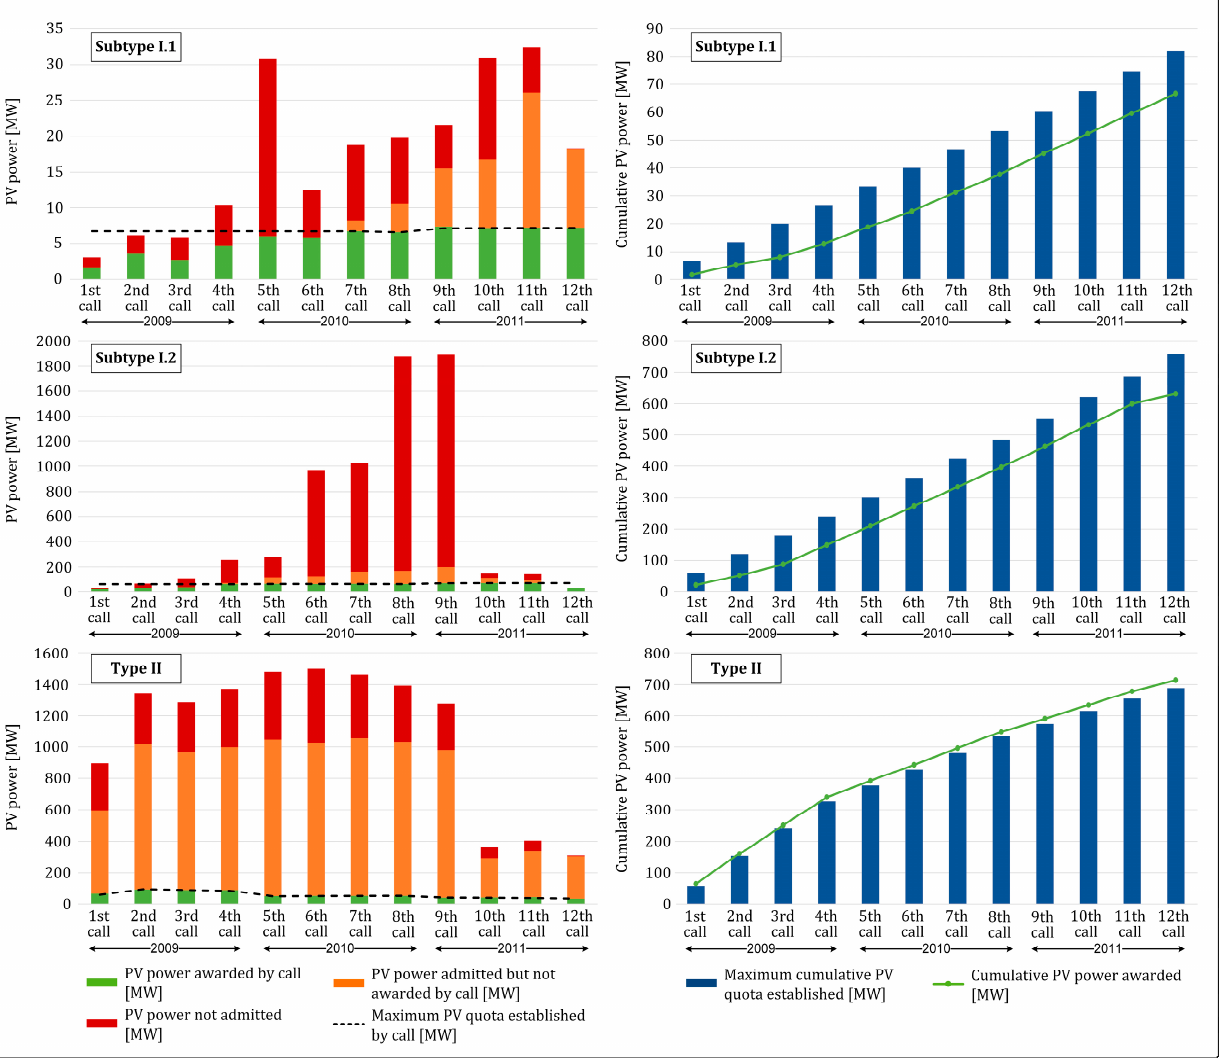
Figure 6. Evolution of the solar PV technology under RD 1578/2008 control structure during the period 2009–2011. Source: self-elaboration based on